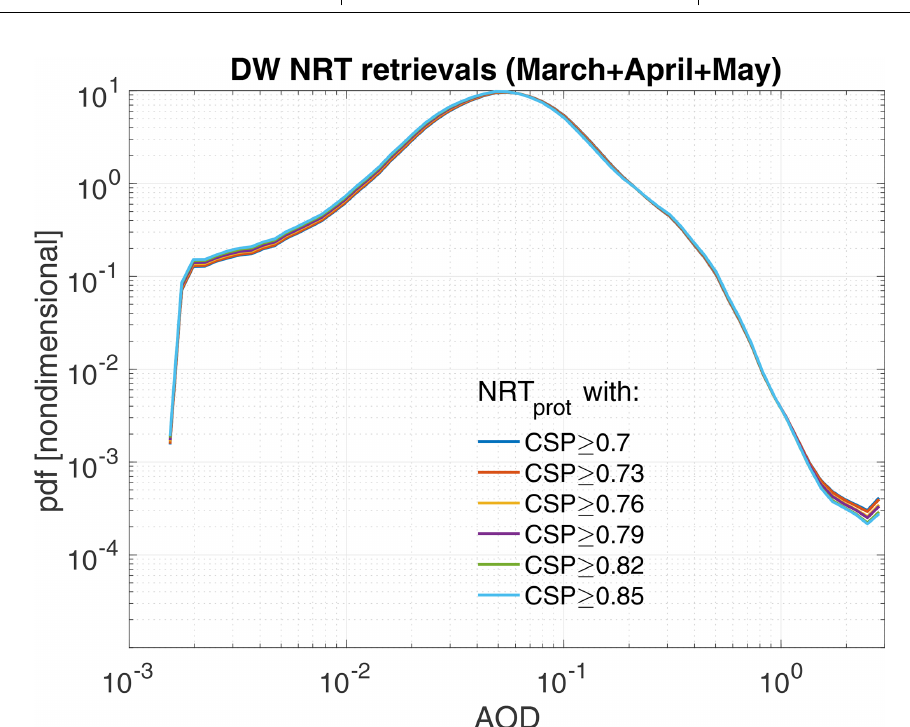
Figure 4. Prototype NRT AOD pdf s over dark water surfaces from spring 2020 obtained with different CSP and CSP9 cloud-screening thresholds. Data statistics are provided in Table